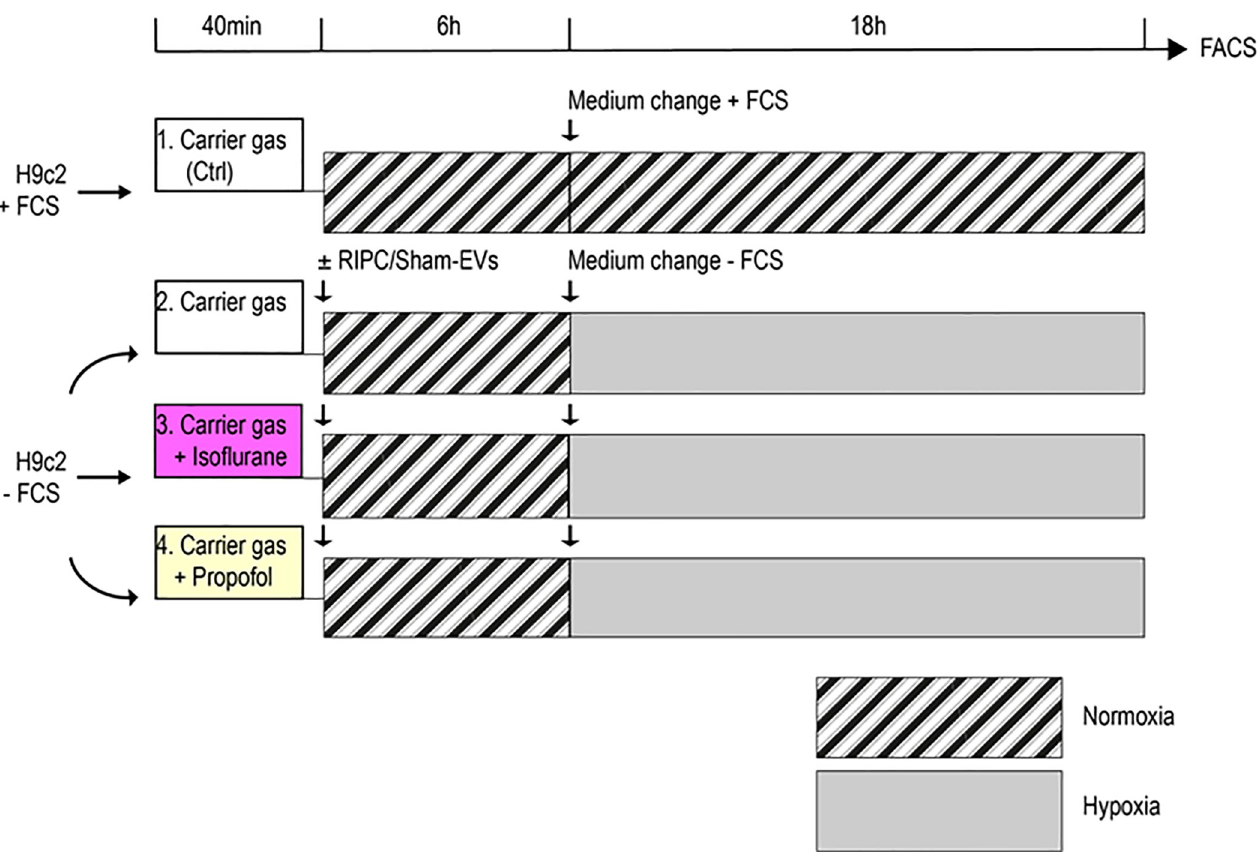
Fig 2. Experimental setup of H9c2 cells exposed to normoxia/hypoxia. Each line represents a different condition. Cells were transferred to 6-well plates and incubated for 24 hours in standard DMEM + 25mM Hepes. The medium was then changed to fresh DMEM + 25mM Hepes ± FCS for each condition. All plates were perfused with normoxic gas (21% O 2 , 5% CO 2 ), whereas one plate was additionally exposed to isoflurane 2% (magenta filled box) and one plate to 50 μ M propofol (yellow filled box). After 40 minutes EVs were added at a concentration of 1x10 9 nanoparticles/ml. Normoxia treated cells did not receive EVs. After incubation for 6 hours, the medium was renewed again to DMEM + FCS in cells under normoxic conditions or to DMEM—FCS in cells undergoing hypoxia. H9c2 cells were then cultured in a normoxic or hypoxic atmosphere (1% O 2 , 5% CO 2 ) for 18 hours. Apoptosis under all experimental conditions was measured by flow cytometry as the endpoint. The hatched boxes illustrate normoxic periods and the grey filled boxes hypoxic periods.